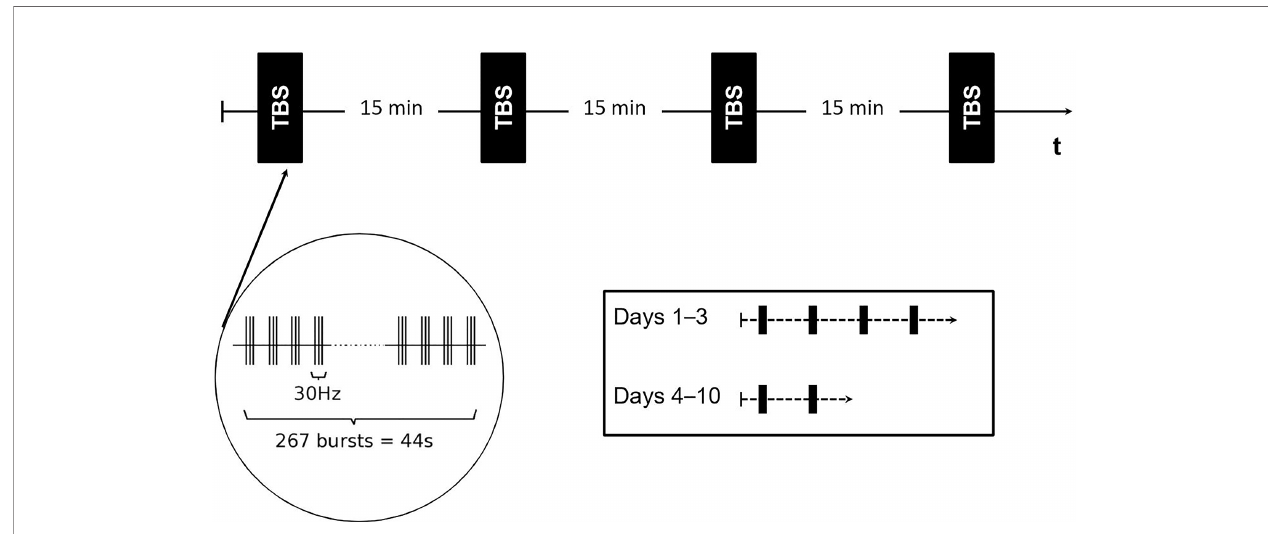
FIGURE 1 | Schematic depiction of the theta-burst stimulation (TBS) protocol on days 1 – 10. The black rectangle represents one stimulus block. Each block was separated by an inter-stimulus interval of 15 min. On days 1 – 3, a series of four stimulation blocks were applied while on days 4 – 10, two stimulation blocks were administered